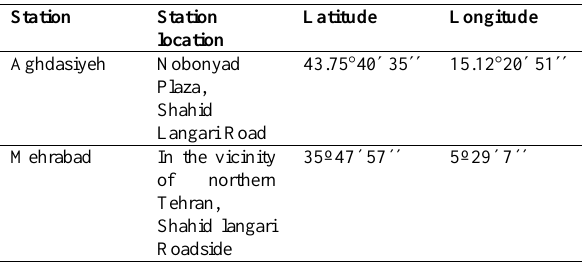
Table 3. Aghdasiyeh and Mehrabad stations .